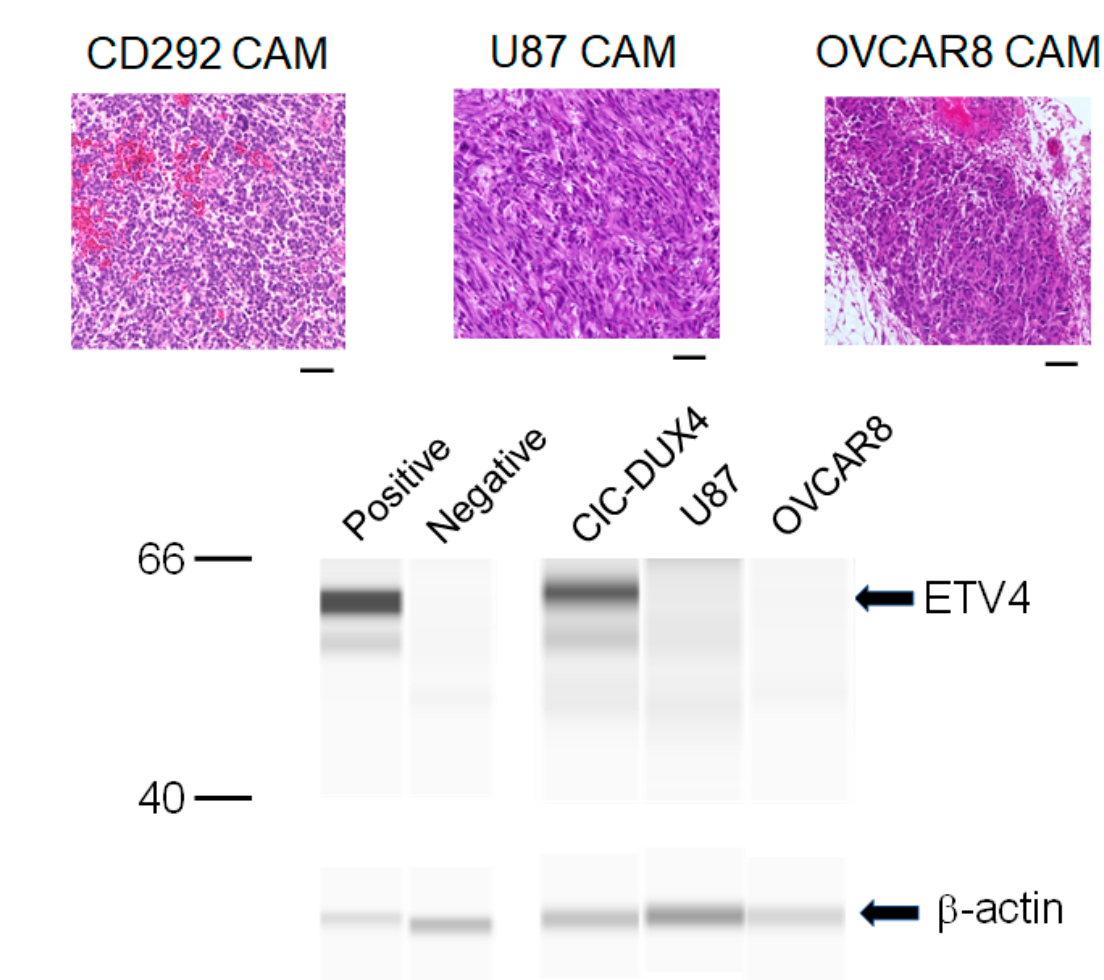
Figure 4. Specific expression of ETV4 in CIC-DUX4 CAM. ( A ): H&E staining of CAM tumors formed by transplanting CD-292 cells (CIC-DUX4 sarcoma), OVCAR8 cells (ovarian cancer) and U87 (glioblastoma). Scale bar represents 0.05 mm. ( B ): Western blot analysis of ETV4 with CIC-DUX4, OVCAR8 and U87 CAM samples. Loading control is β -actin which is shown in the lower panel. Proteins extracted from CAM membrane were used as a negative control, while proteins extracted from CD-292 cells were used as a positive control.